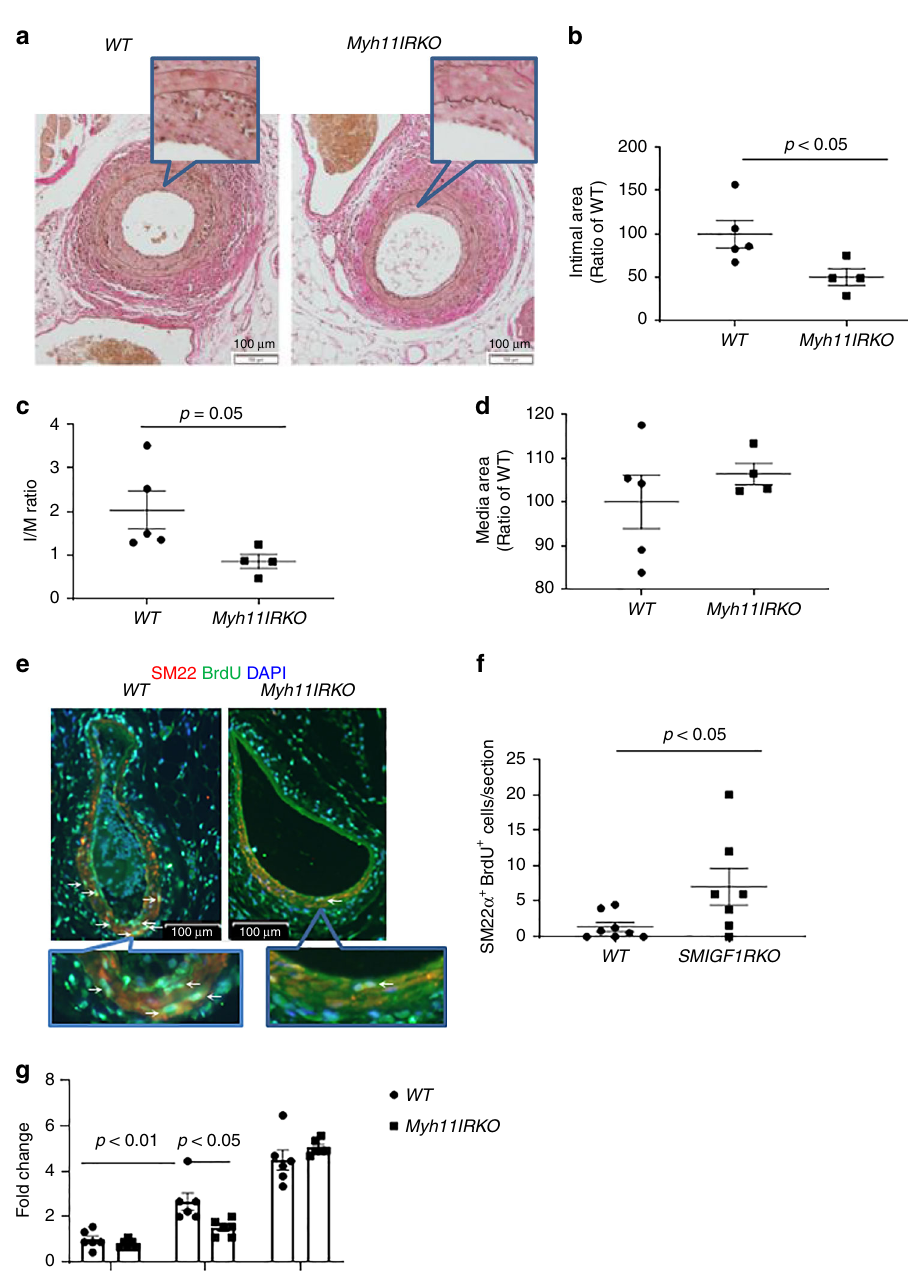
Fig. 1 Wire injury-induced femoral artery intimal hyperplasia in HFD-fed WT and Myh11IRKO mice. a – d Intimal hyperplasia was determined by elastin staining. a indicates representative images. Summarized intimal area ( b ), intima/media (I/M) ratio ( c ), and media area ( d ) are shown ( WT , n = 5; Myh11IRKO , n = 4). e , f VSMC proliferation in the wire-injured femoral artery. The femoral arteries were subjected to wire injury, and then the mice were infused with Brdu with osmotic minipump for 1 week. VSMCs proliferation was determined by SM22 α and Brdu double staining. e indicats representative images, and f shows summarized data ( WT , n = 8; Myh11IRKO , n = 7). g Insulin and IGF-1 induced VSMCs proliferation. Starved WT or Myh11IRKO VSMCs were stimulated with insulin (10 nM) or IGF-1 (10 nM) for 24 h, and cell proliferation was determined by Edu incorporation and measured by fl ow cytometry ( n = 6 per group). The data are mean ± SEM. Two-tailed t test ( b , c , d , f ) or two-way ANOVA with a post hoc test ( g ). Source data are provided as a Source Data fi body weights, plasma lipid, IPGTT, and IPITT were not different Sections of wire-injured femoral artery from WT or between the two groups of mice (Supplementary Fig. 7A – E). SMIGF1RKO mice were stained with VSMC marker SM22 α or Intimal area of the femoral artery was increased by 45% in macrophages marker Mac2. VSMC numbers in the intimal area SMIGF1RKO mice compared with WT mice (Fig. 2a, b). The of femoral artery from SMIGF1RKO mice were increased by 50% intima/media ratio, which is the gold standard for restenosis, and compared with that of WT mice. The macrophages and the media area were not different between WT and SMIGF1RKO collagen content (trichrome staining) in the intimal area of mice (Fig. 2c, d). femoral artery of WT mice were not different compared with that